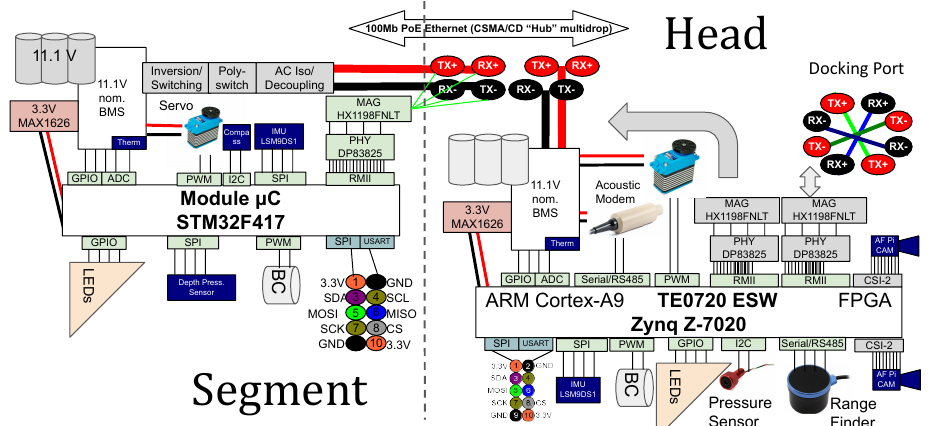
Figure 7. Simplified Electronic System Design of RoboFish; Modular Software and Hardware Architecture; Each Module is